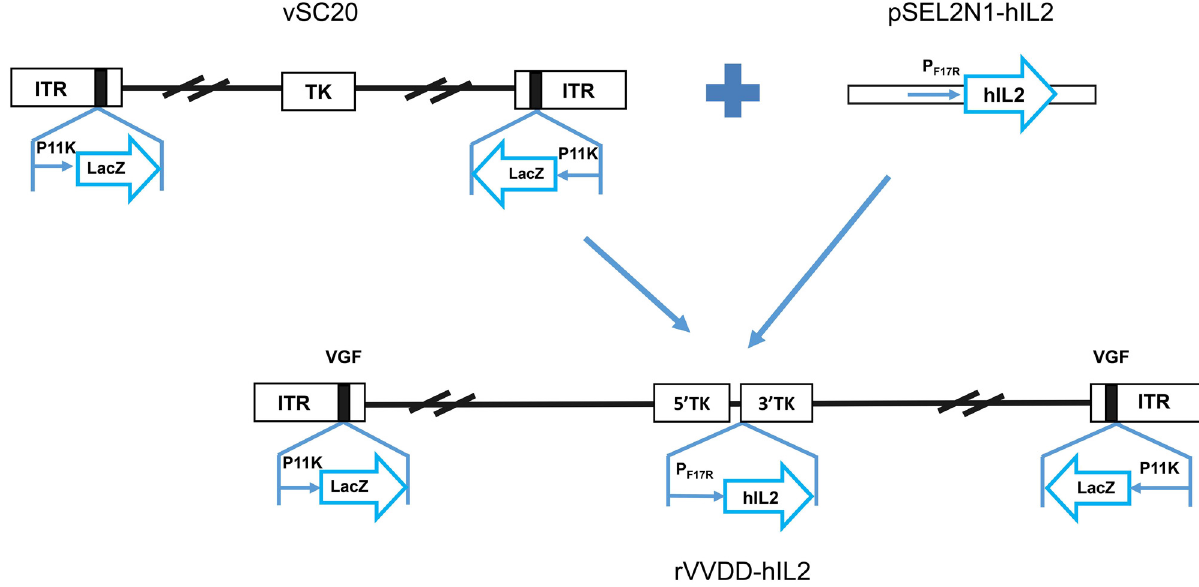
Figure 1: Schematic structure of rVVDD - hIL2 encoding a human IL2 expression